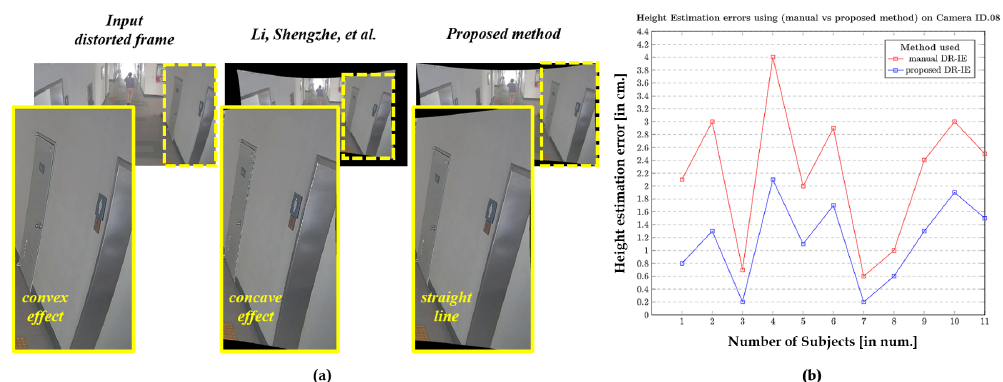
Figure 19. Height Estimation errors using (Li, Shengzhe et al. [31] vs. proposed method) on Indoor camera ID.08: ( a ) Qualitative pixel-consistency. ( b ) Height estimation error plot corresponding to all the 11